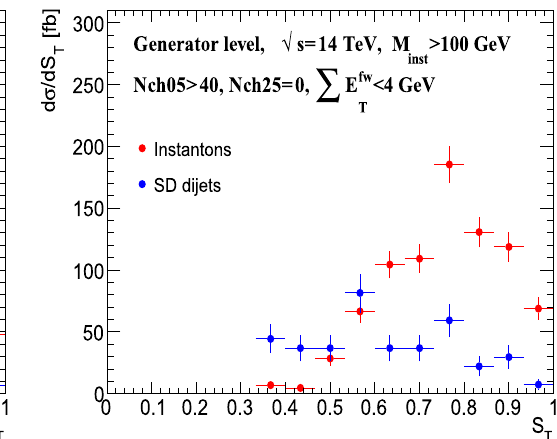
Fig. 2 Differential cross-section as a function of transverse spheric- ity at generator level separately for the instanton signal from proton– Pomeron collisions ( M inst > 60 GeV on the left and M inst > 100 GeV